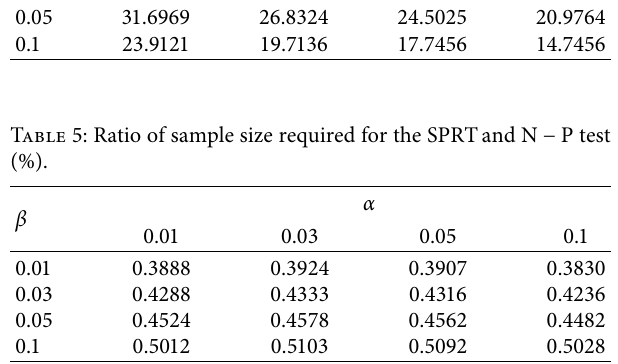
Table 4: Sample size required for the N − P test method. β 0.01